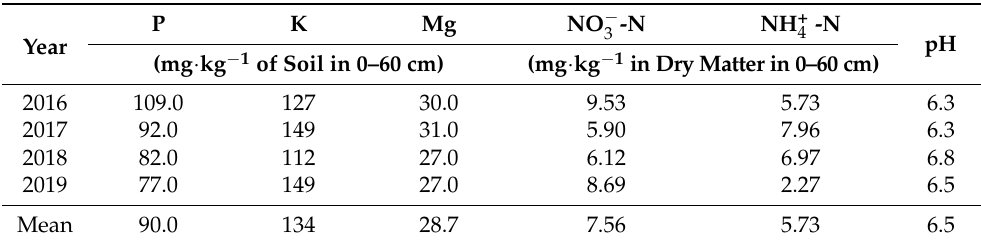
Table 1. Chemical properties of soil prior to pea sowing in